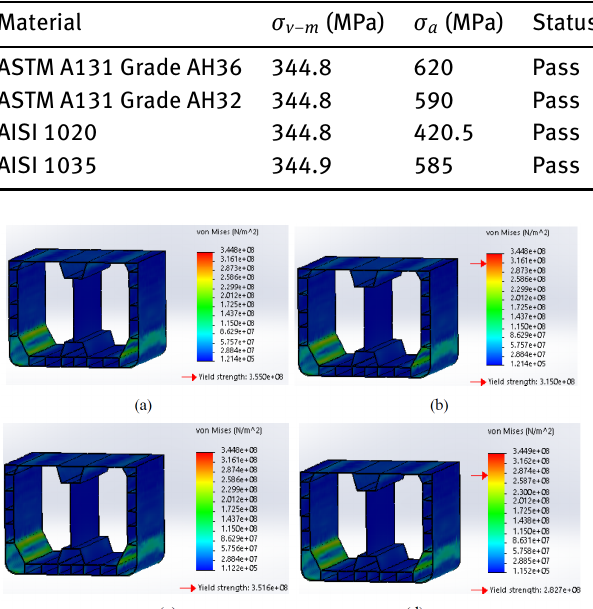
Table 4: von Mises stress results and statuses for different material types.